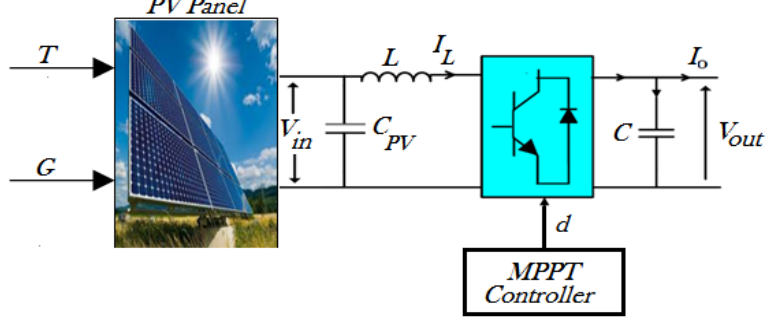
Figure 4. Boost converter equivalent circuit with MPPT.